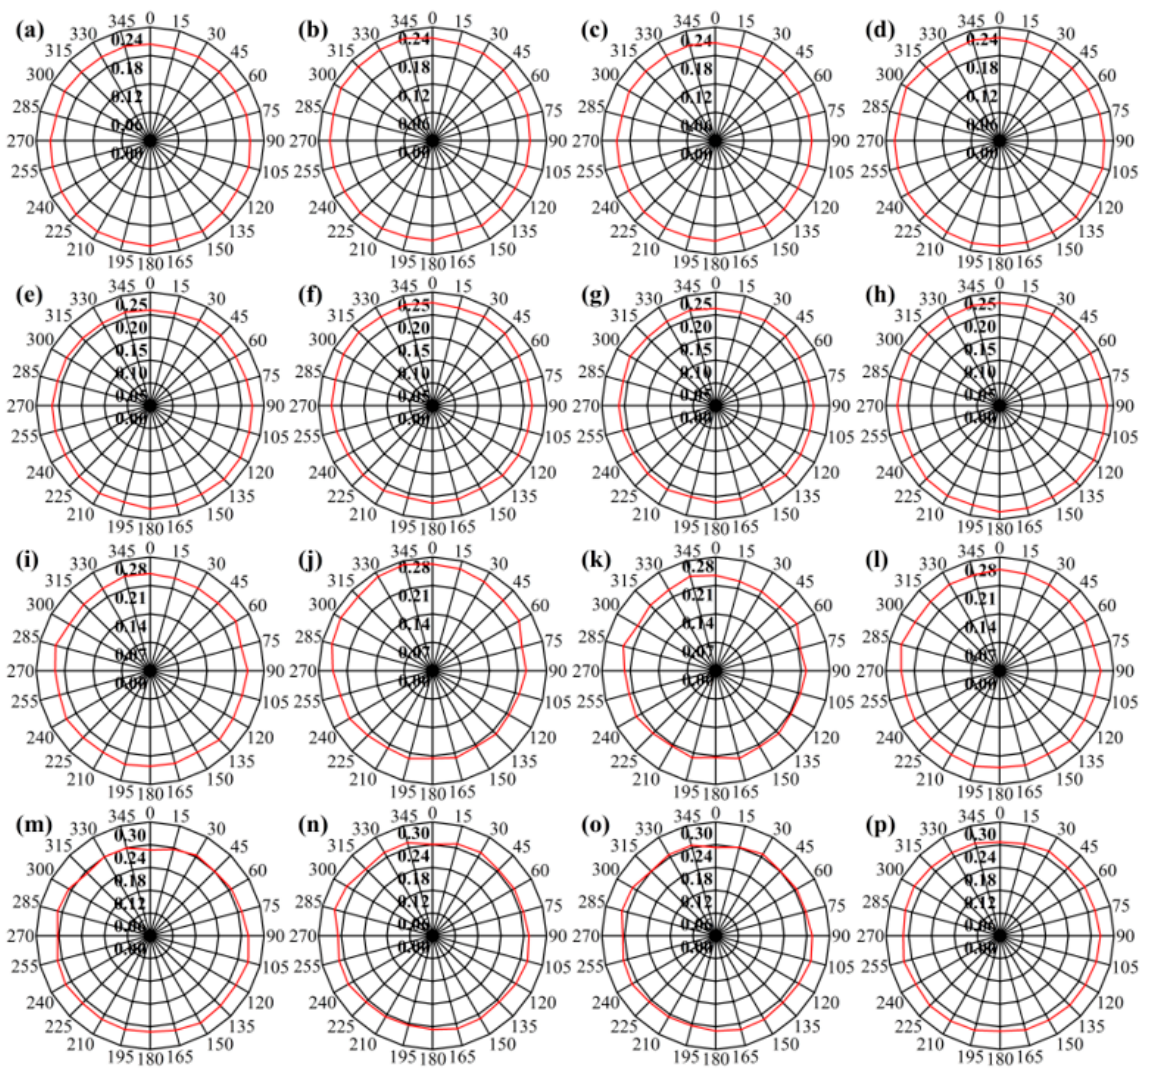
Figure 8. The average reflectance of herb ( a – d ), shrub ( e – h ), tree ( i – l ), and bare soil ( m – p ) in different aspects. The radius represents the magnitude of the reflectance with zero in the center, and the polar angle represents the aspect. ( a ) Uncorrected, ( b ) SCS+C, ( c ) Minnaert+SCS, ( d ) RA-TOC-CA; ( e ) Uncorrected, ( f ) SCS+C, ( g ) Minnaert+SCS, ( h ) RA-TOC-CA; ( i ) Uncorrected, ( j ) SCS+C, ( k ) Minnaert+SCS, ( l ) RA-TOC-CA; ( m ) Uncorrected, ( n ) SCS+C, ( o ) Minnaert+SCS, ( p ) RA-TOC-CA. Table 4. The coefficient of variation (%) of reflectance across different aspects.